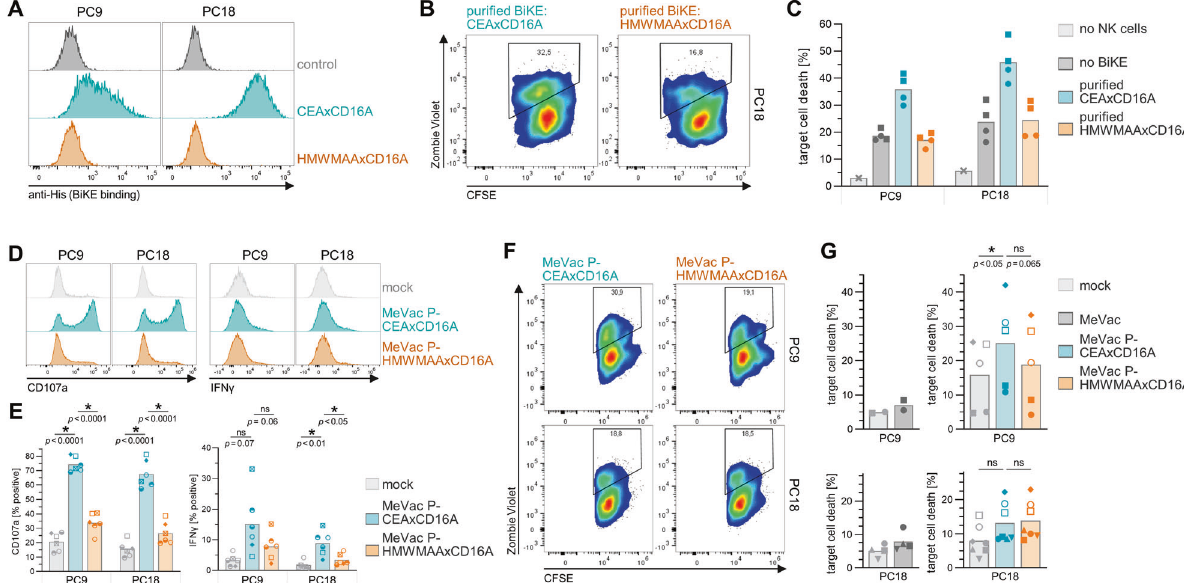
Fig. 5 MV-BiKE ef fi cacy against patient-derived pancreatic cancer cultures. A BiKE binding to pancreatic cancer cultures. BiKEs were puri fi ed from supernatants of Vero producer cells infected with respective viruses (vBiKEs). Cancer cells were incubated with CEAxCD16A vBiKEs or the HMWMAAxCD16A control. Binding was assessed via fl ow cytometry based on BiKE labeling with anti-His 6 antibodies. Histograms for PC9 and PC18 are depicted. B , C NK cell cytotoxicity upon vBiKE treatment. Allogenic, IL-2 pre-stimulated NK cells were co- incubated with CFSE-labeled PC9 or PC18 cultures (E:T = 5:1) in presence of vBiKEs (5 ng/µL) for 12 h with subsequent analysis of target cell death via fl ow cytometry. B Pseudocolor plots exemplarily illustrate gating and CFSE + tumor cell viability for PC18 based on Zombie Violet staining of dead cells. C Target cell death for n = 2 donors with technical duplicates per donor is shown. D – G NK cell activity upon infection of patient-derived cultures with MV-BiKE. Infected cancer cells were cocultured with CFSE-labeled, non-infected target cells and allogenic, IL-2 pre-stimulated NK cells for 12 h (compare Fig. 3A). NK cell degranulation, cytokine expression, and target cell killing were analyzed by fl ow cytometry. D NK cell degranulation (CD107a) and intracellular IFN γ accumulation in response to MV-BiKE therapy are depicted in exemplary histograms. E Mean percentages of CD107a + and IFN γ + NK cells are shown for n = 6 donors with different symbols representing individual donors. F Pseudocolor plots display the viability of non-infected CFSE + target cells in coculture with respective MV-BiKE infected cancer cells and NK cells. G Mean percentages of target cell death in designated cocultures are summarized for n = 5 donors (PC9, top) and n = 7 donors (PC18, bottom) with donors represented by symbols as in ( E ). Statistical analysis was performed by one-way ANOVA with Š idák ’ s multiple comparisons